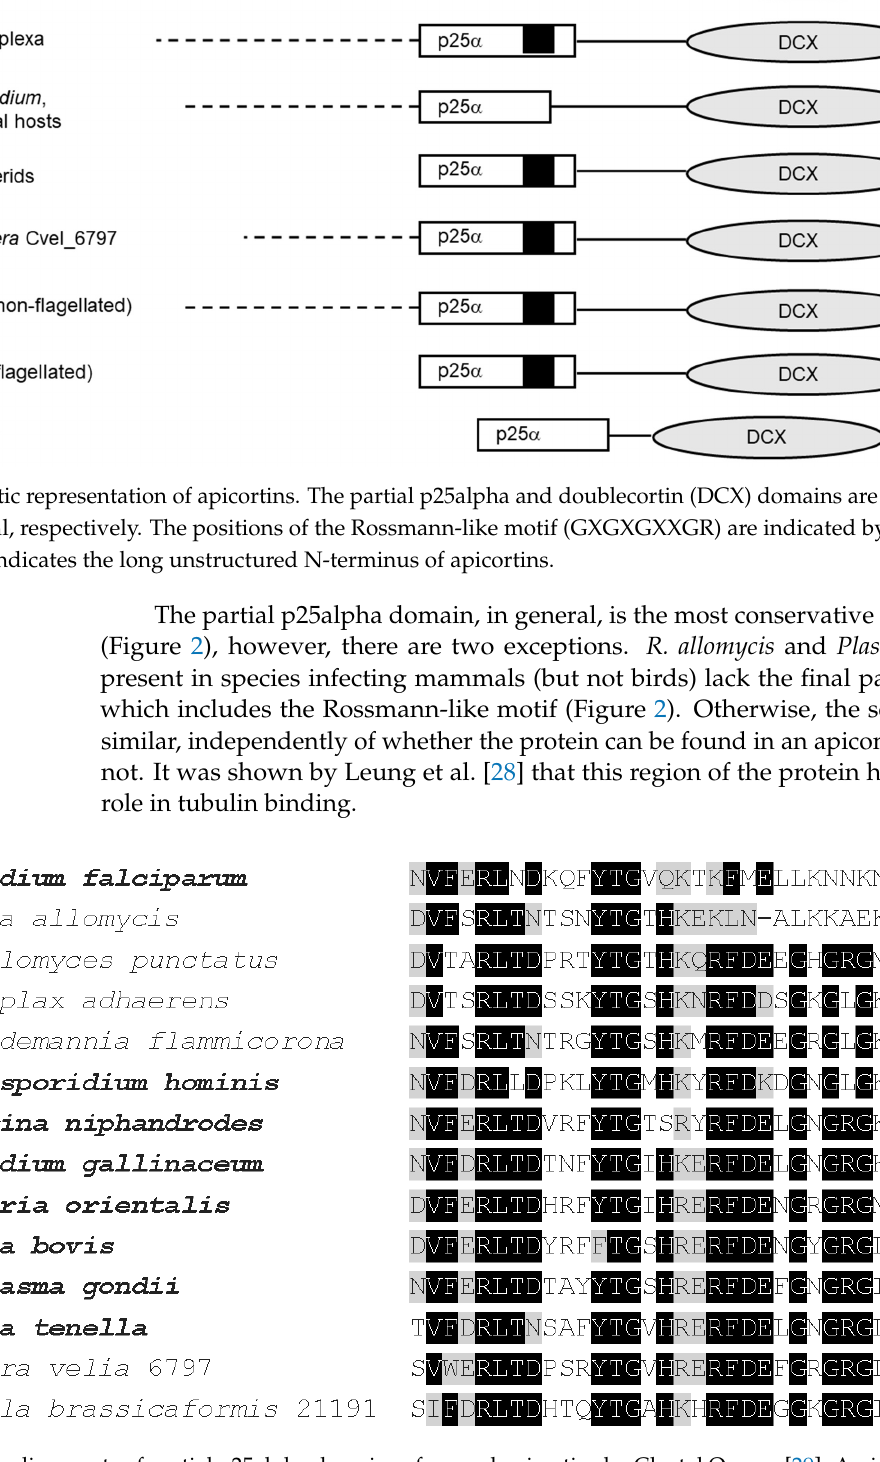
Figure 2. Multiple alignments of partial p25alpha domains of several apicortins by Clustal Omega [29]. Amino acids, which are identical and biochemically similar in the majority of the proteins, are indicated by black and gray shading, respectively. Bold letter indicates apicomplexan species.